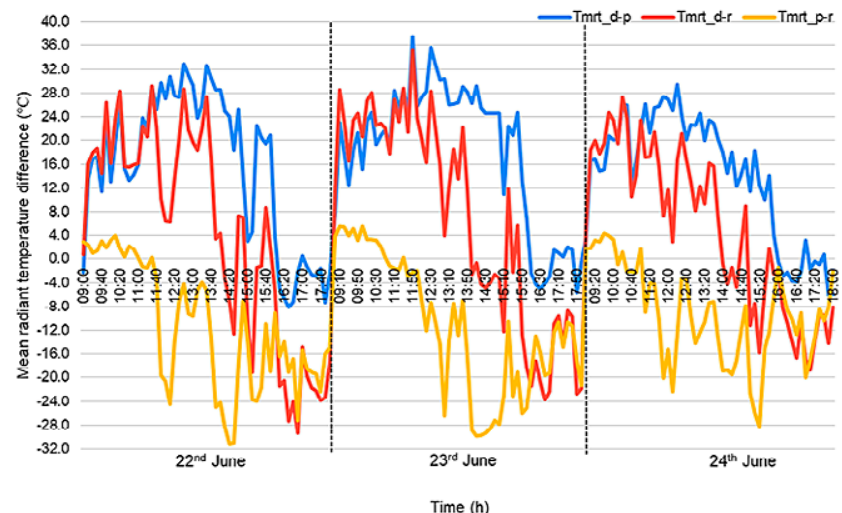
Figure 7. Temporal variation of T in Banja Luka (Bosnia and Herzegovina) in the period 22-24 June 2021 mrt (measurement period 9-18 h CEST). NOTE: T represents Mean Radiant Temperature difference between mrt_d-p downtown and urban park; T represents Mean Radiant Temperature difference between downtown and riverside; mrt_d-r and T represents Mean Radiant Temperature difference between urban park and mrt_p-r